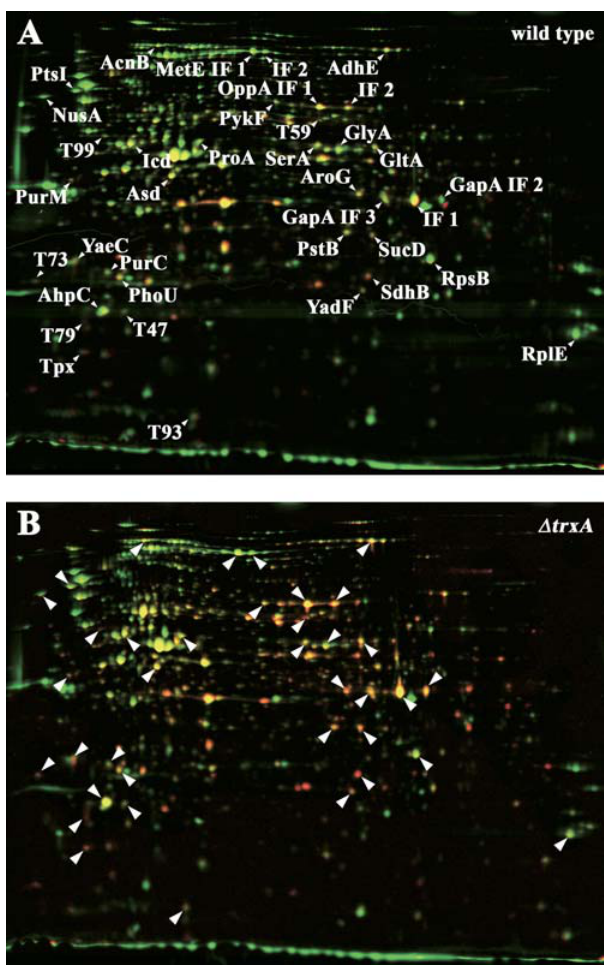
Figure 4. Identification of the In Vivo Substrate Proteins of Thioredoxin A (A) Colored overlay of the stained 2D gel (shown in green) and the phosphor image (shown in red) of differentially trapped protein extract from exponentially growing E. coli wild-type cells. Proteins with a high ratio of activity per protein appear red, proteins with a low ratio appear green. Proteins that were found to have a significantly higher ratio of activity per protein in the trxA (cid:2) strain (B) are labeled. (B) Overlay of the stained 2D gel (shown in green) and the phosphor image (shown in red) of differentially trapped protein extract from exponentially growing E. coli D trxA cells. Proteins that were found to have a significantly higher ratio of 14 C activity/protein in the D trxA strain are labeled with an arrow. DOI: